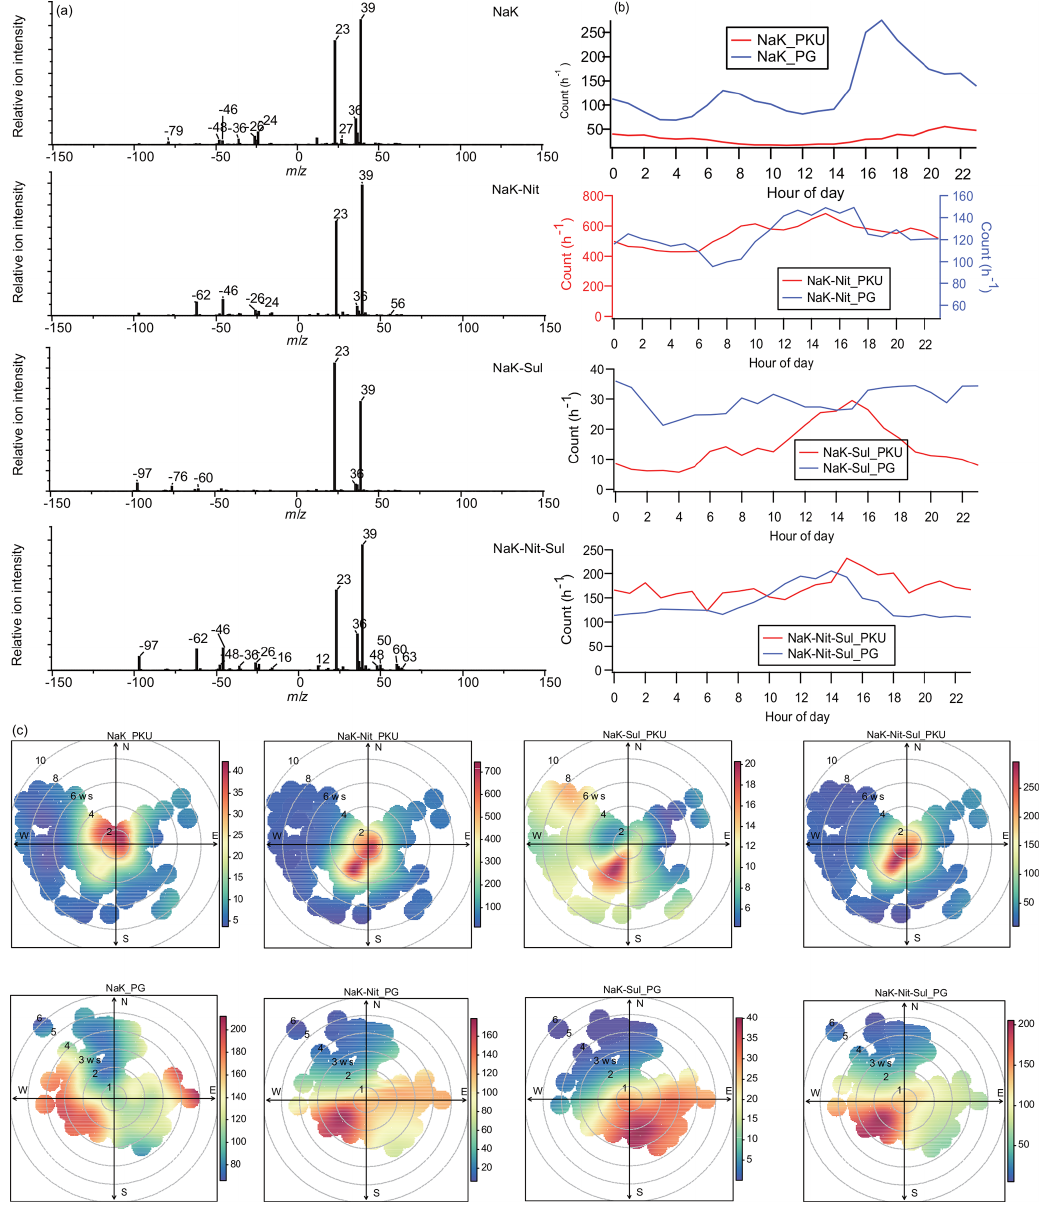
Figure 8. (a) Average mass spectra of NaK, NaK-Nit, NaK-Nit-Sul, and NaK-Sul observed at both sites; (b) diurnal patterns of the hourly count of NaK, NaK-Nit, NaK-Nit-Sul, and NaK-Sul at both sites; (c) polar plots of NaK, NaK-Nit, NaK-Nit-Sul, and NaK-Sul; the gray circles indicate wind speed (ms 1